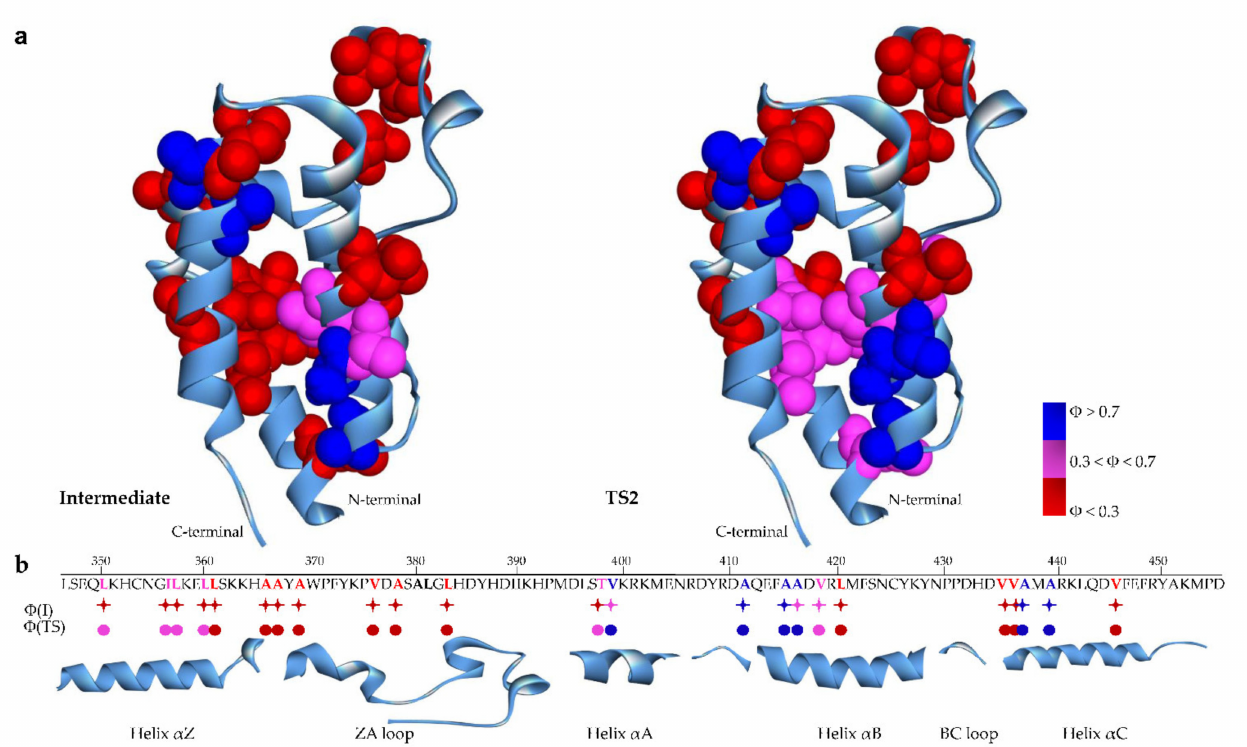
Figure 3. The structure and sequence of BRD2(2) (PDB: 3ONI). ( a ) Structural distribution of the measured Φ values on the structure of BRD2(2) in the intermediate (I) and in the transition state (TS2), respectively. The experimentally determined Φ values were divided into three categories and reported on the structure using the following code color: red, 0 < Φ < 0.30; magenta, 0.30 < Φ < 0.70; blue, 0.70 < Φ < 1.00. ( b ) Secondary structural elements are shown at the bottom of the amino acid sequence. Mutated residues are depicted in bold. The dots and asterisks under the sequence are colored according to the color code shown in ( a